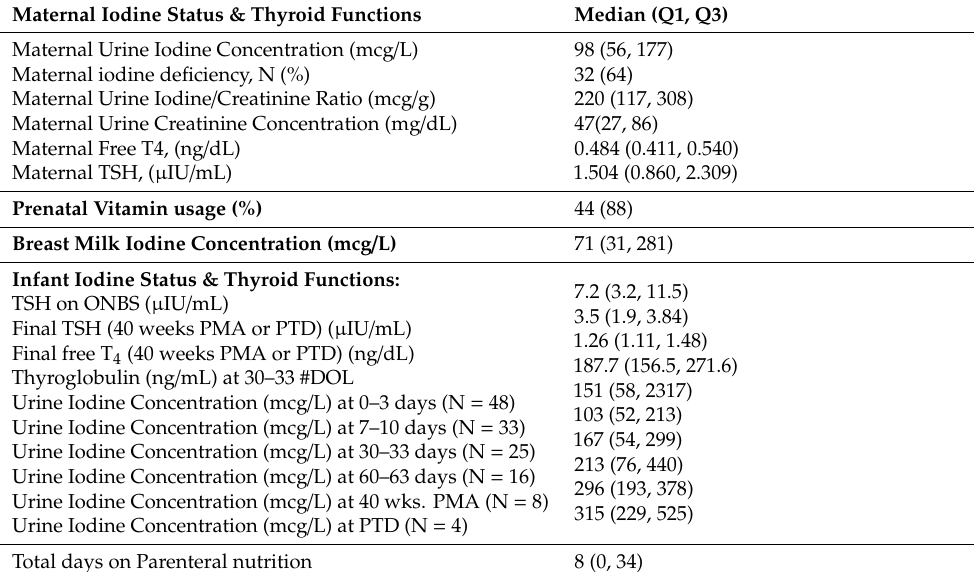
Table 2. Maternal and Neonatal Clinical Characteristics.